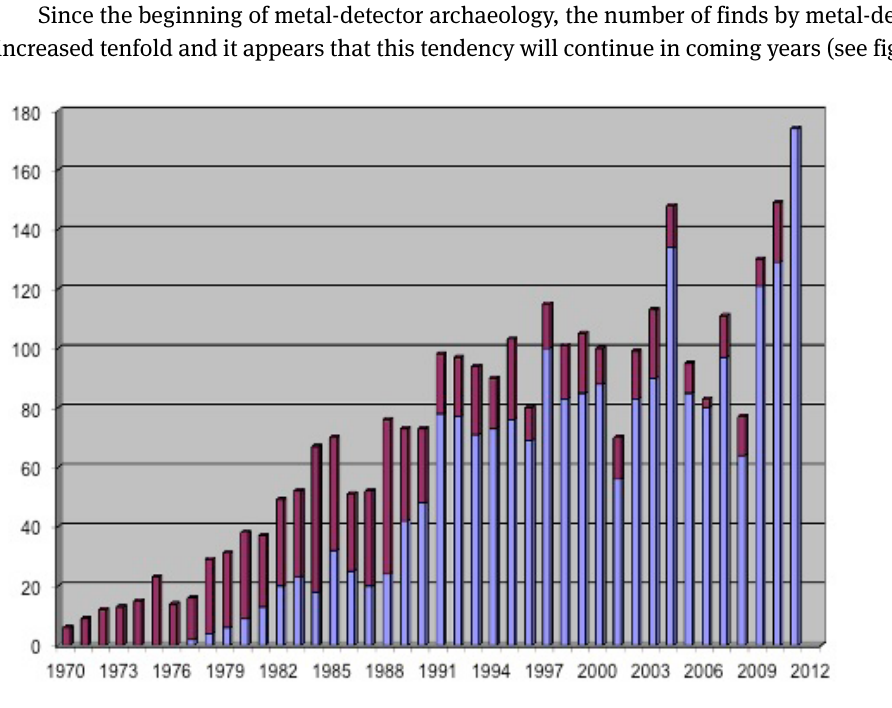
Figure 1: Increase in the number of findspots that have produced treasure trove finds discovered with (blue) or without (red) metal detectors in Denmark during the period 1970–2011. The substantial majority of the non-metal detector treasure trove finds are of stone, amber or glass (the decrease between 2006 and 2008 is explained by administrative issues and does not reflect actual circumstances). The Danish National Museum is unable to provide data for the time after